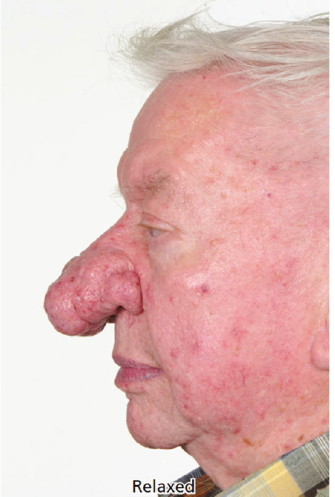
Figure 3: Case 3, preoperative lateral